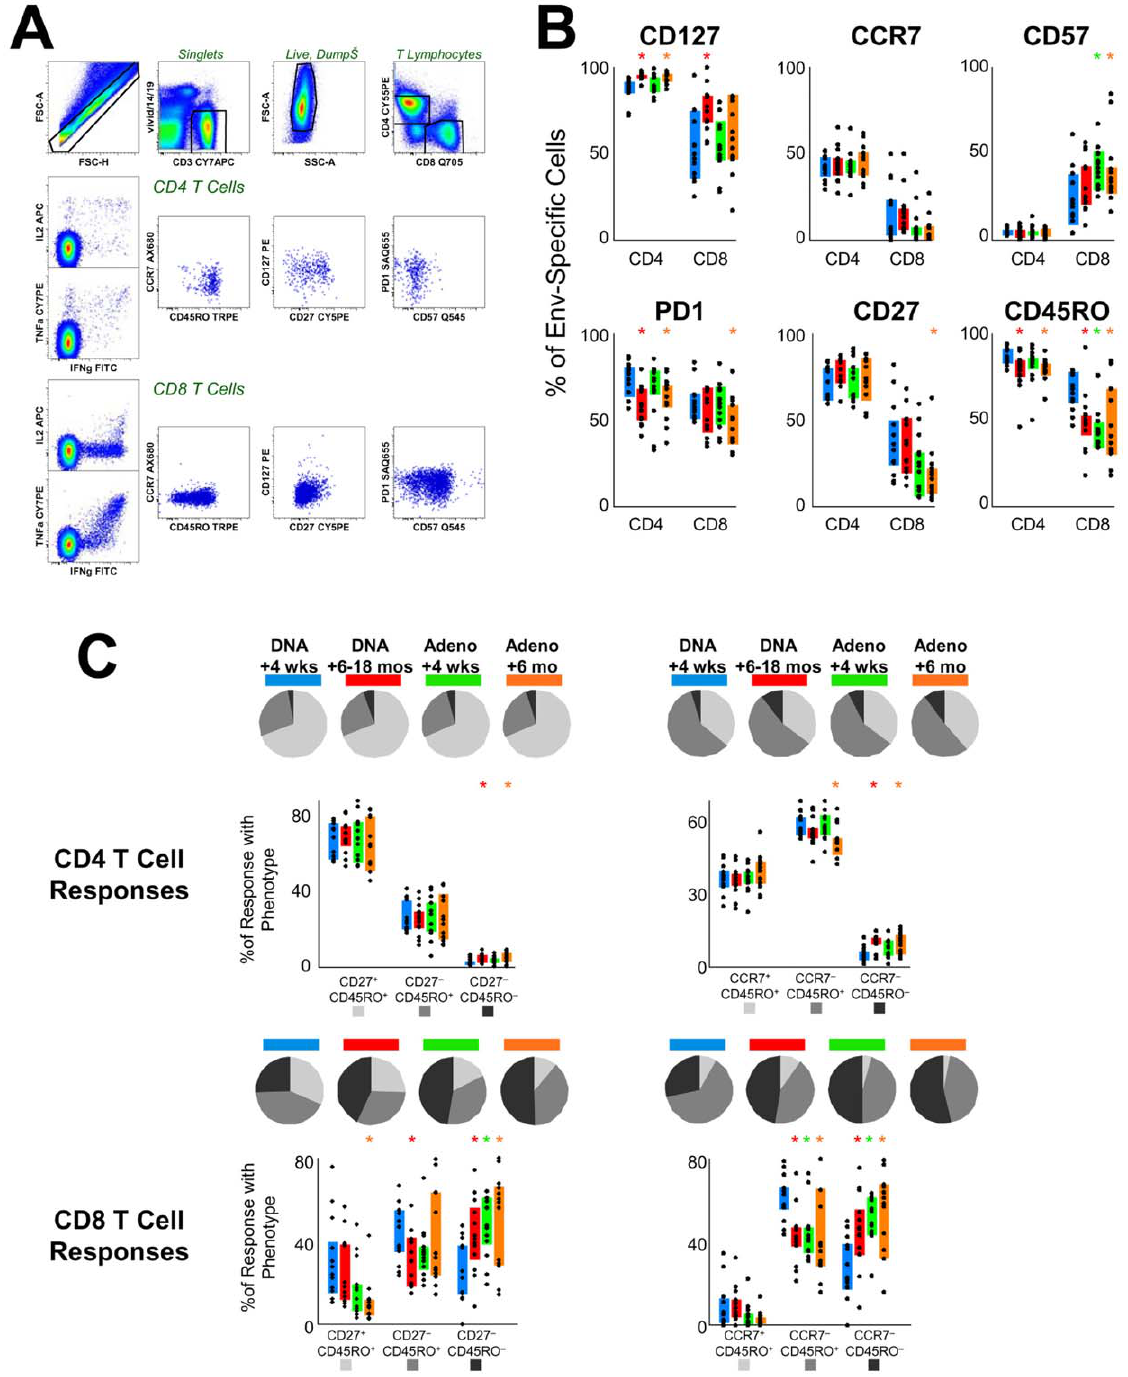
Figure 2. Phenotype of vaccine-induced T cells. (A) Flow cytometric analysis of antigen-specific T cells. The top row of graphs shows the progressive gating to identify live CD3 + CD4 + or CD3 + CD8 + lymphocytes. For either CD4 or CD8 T cells, antigen-responsive cells (following in vitro stimulation) are identified by the production of IL2, IFN- c , or TNF. This example shows EnvA-stimulated cells from one of the highest responders in the study; the phenotyping graphs illustrate the distribution of cells that make any cytokine (blue) overlaid on the total CD4 or CD8 population (grey). (B) The distribution of expression of a variety of cell surface markers on antigen-specific CD4 or CD8 T cells following vaccination. The colored bars represent the IQR for the distribution at different time points: 4 weeks post-DNA (blue); 6–18 months post DNA (red); 4 weeks post rAd5 boost (green); and 6 months post-boost (orange). (C) Two different phenotyping schemas, based on either CD27 or CCR7 expression in combination with CD45RO, were used to characterize antigen-specific T cells. The bar charts show the individual data points and IQR for the four time points following immunization. The pie charts summarize these distributions, showing the average proportion of the CD4 or CD8 vaccine-specific T cell response that is T CM (light grey), T EM (medium grey), or T EF (black). Asterisks indicate distributions that are different from the earliest time point (4 weeks post DNA) at p , 0.05 (Student’s T test).